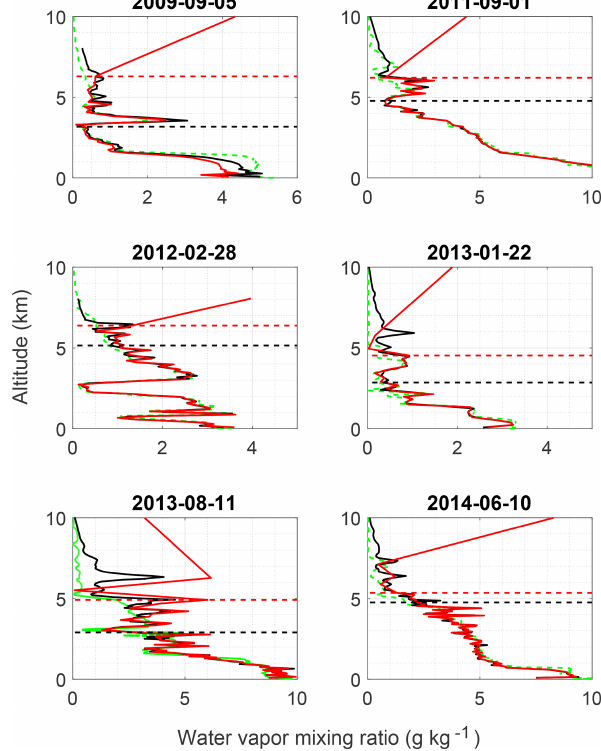
Figure 7. Daytime water vapor mixing ratio retrievals for 5 ad- ditional nights. Black lines are the original OEM retrieval on the fine grid, red solid lines are the ML coarse-grid retrievals, and the dashed green lines are the radiosonde mixing ratio measurements. The black dashed line is the original 0.9 measurement response cut- off height, and the red dashed lines are the coarse-grid cutoff heights which were chosen as the last altitude whose measurements had less than 60% total